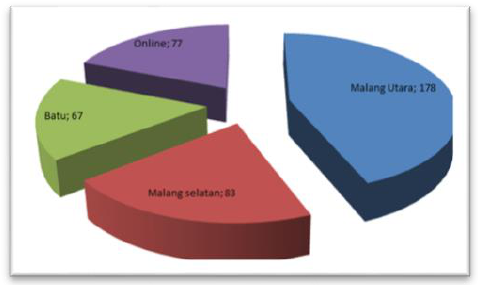
Figure 1: Respondents’ count by place